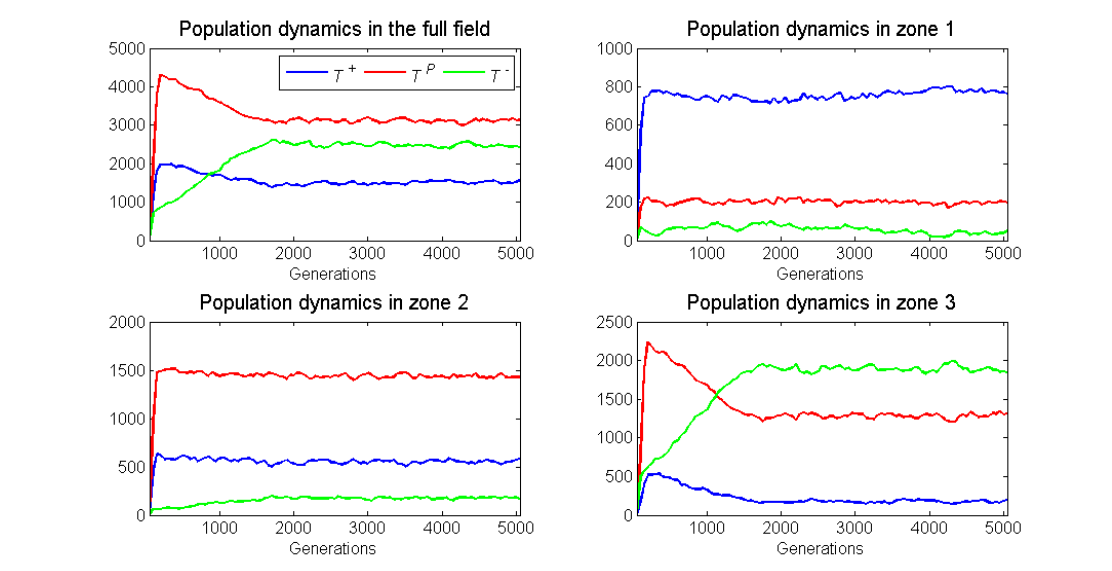
Figure 6. The population dynamics for the simulation shown in Figure 4. The four panels show the population sizes of the three cell types across the entire torus, zone 1, zone 2 and zone 3. In this case, an isolated cell cannot proliferate and the blood vessel remains in a fixed location. Examination of the five replicate runs for σ = 0 and σ = 0.1 revealed that the standard